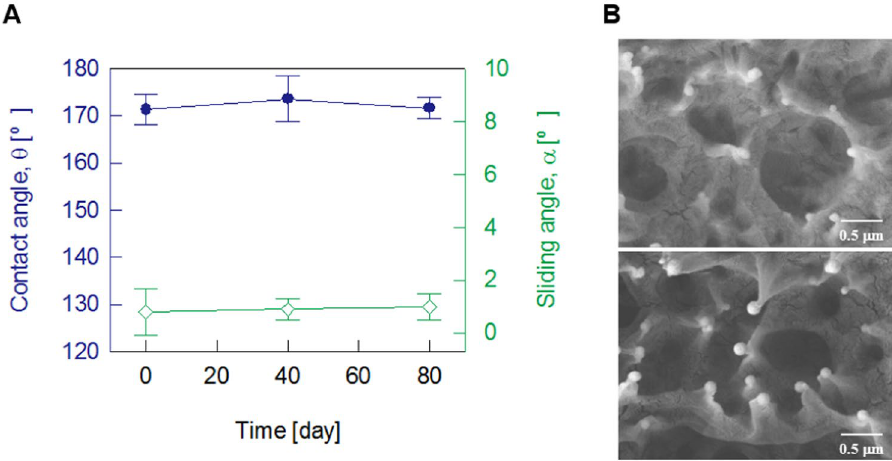
Figure 3. Surface durability of the fabricated PTFE sheets exposed to air for a long time. ( A ) The contact angle and the sliding angle of the superhydrophobic PTFE sheets (n = 6) are almost maintained after 80 days of air-aging. ( B ) SEM images before the aging test (top) and after 80 days of exposure to air (bottom). The crown- shape bumps are almost